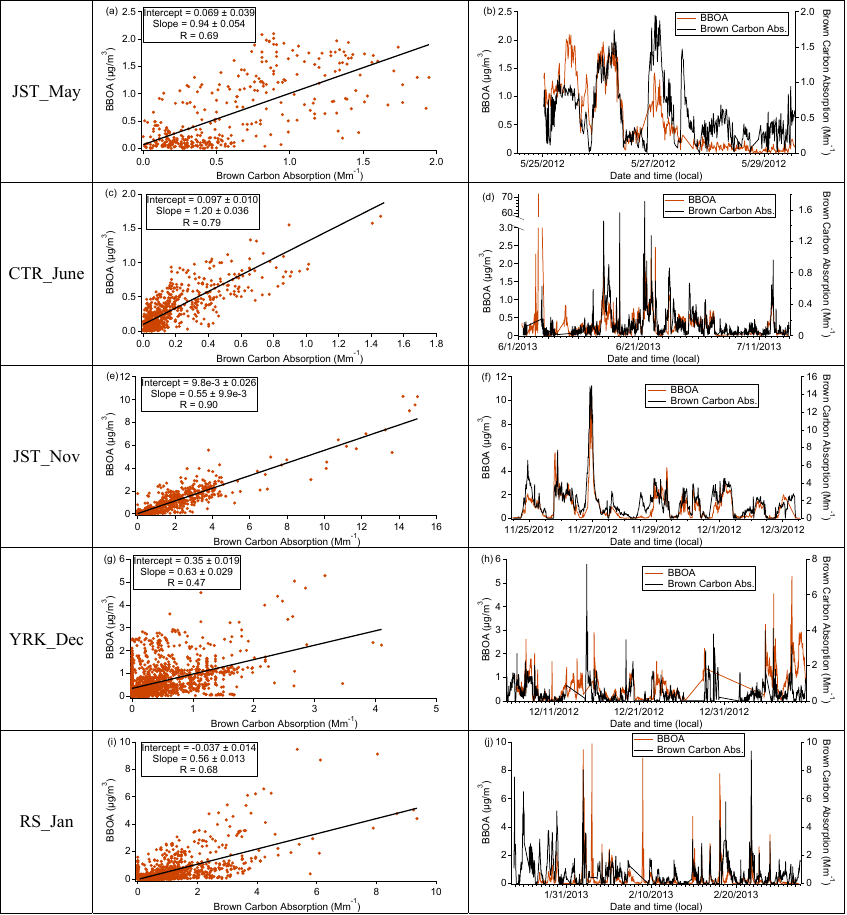
Figure 7. Scatter plot (left panel) and the time series (right panel) of BBOA and brown carbon light absorption for the data sets where a BBOA factor was